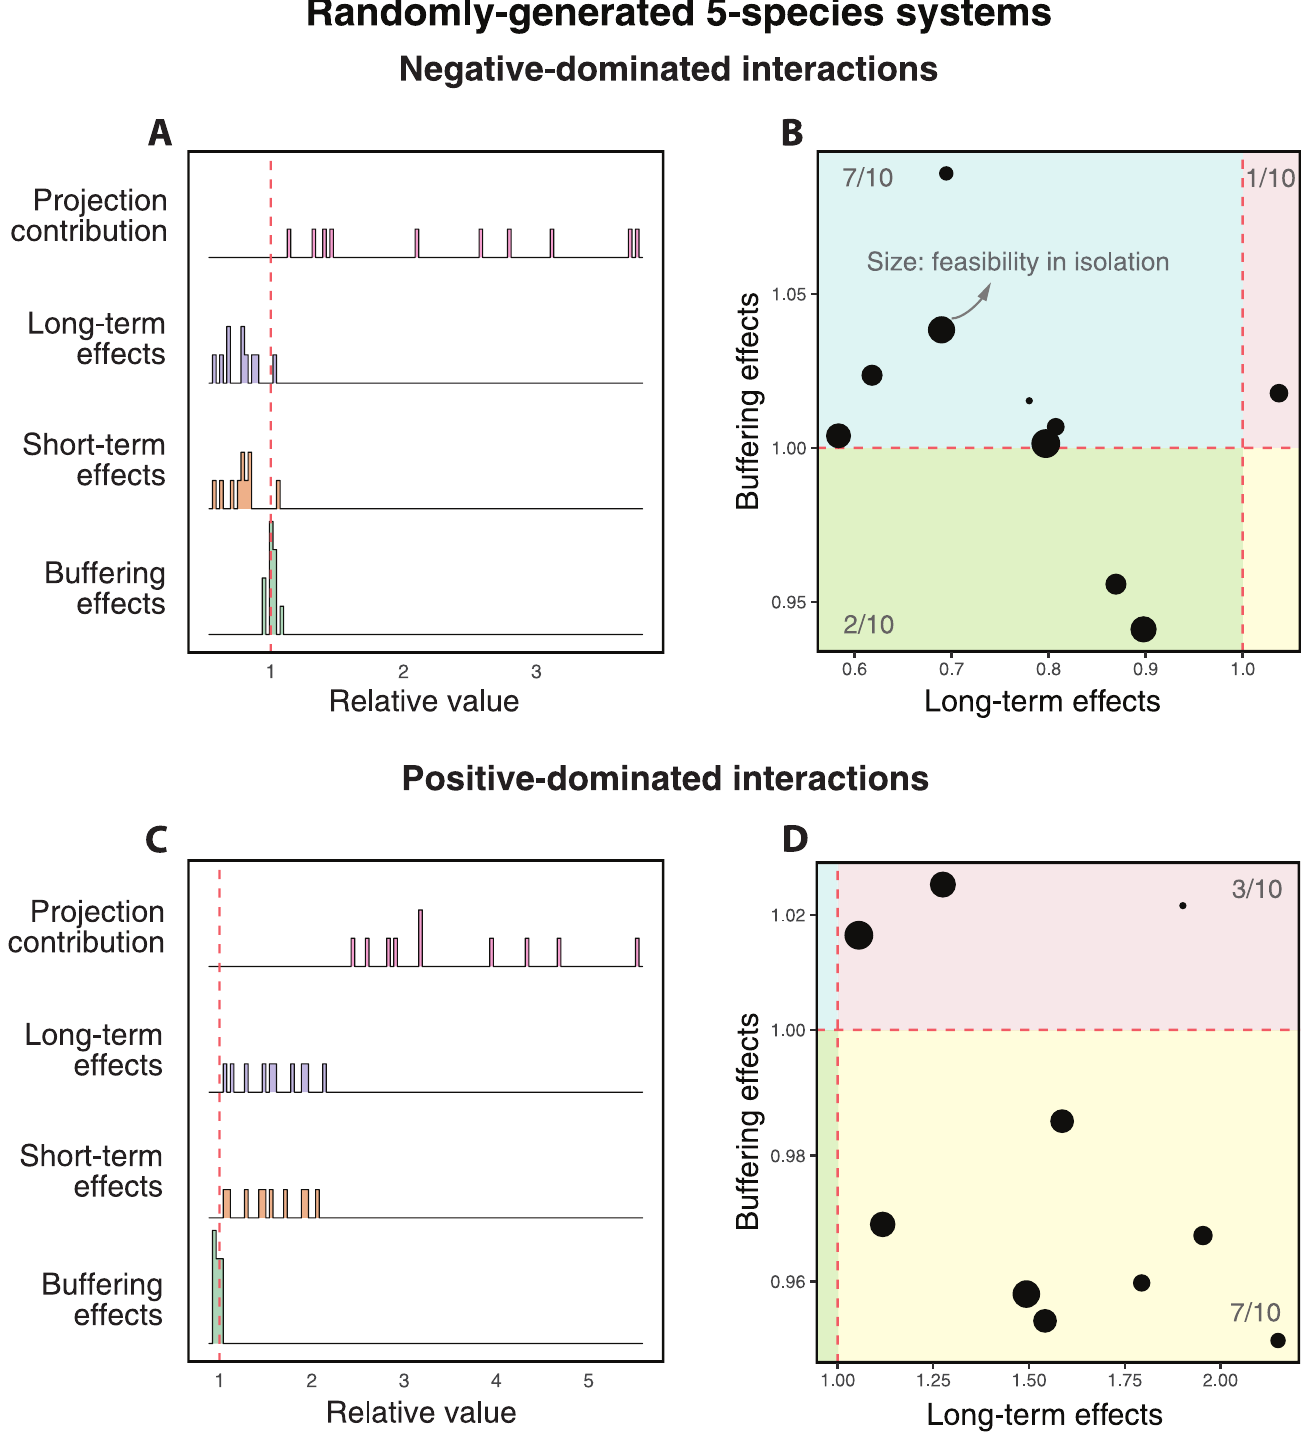
PLOS Computational Biology | https://doi.org/10.1371/journal.pcbi.1010630 October 24,